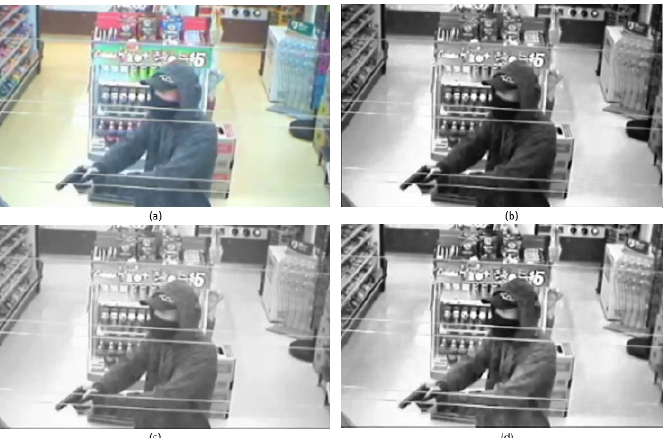
Figure 3. Image filtration using OpenCV filters; top left to bottom right ( a – d ): ( a ) actual image, ( b ) equalized filter result, ( c ) gray scale filter result, and ( d ) CLAHE filter result.